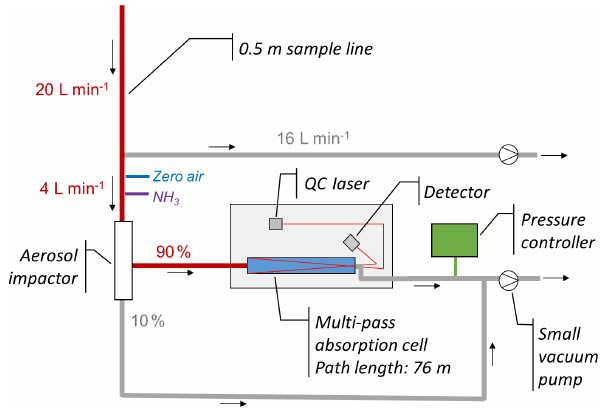
Figure 2. Setup of the QC-TILDAS on the Twin Otter aircraft for NH 3 measurements at 1Hz sample frequency. The commercially available QC-TILDAS was modified using a smaller vacuum pump, a pressure controller and a custom-made PFA aerosol impactor. To achieve an optimal time response, the used inlet line was only 0.5m, and a bypass system was used to generate a higher flow rate through the inlet line. The distances from the bypass to the aerosol impactor and from the aerosol impactor to the instrument’s sample intake were also kept as short as possible ( < 10cm). See text for further details on the